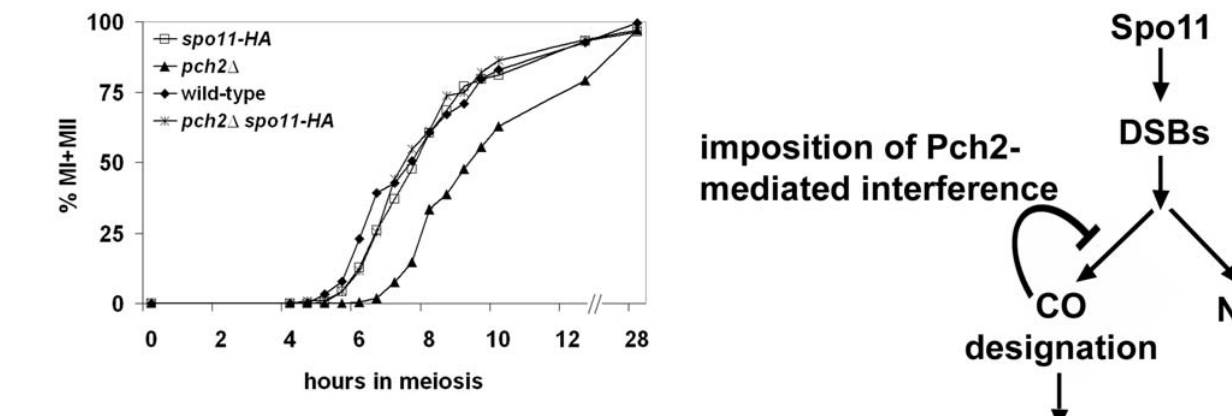
Figure 6. The pch2 D MI delay is suppressed by the spo11-HA hypomorph. Synchronous cultures were induced to undergo meiosis and progression past MI (MI 6 MII) was assayed in the NHY background for wild-type (diamonds), spo11-HA (open squares), pch2 D (triangles), and pch2 D spo11-HA (stars; Materials and Methods). A representative time course is Table 3). In other words, we propose Pch2-mediated CO control acts not only to uniformly space COs within the genome, but also to limit the overall number of COs. The same defect in pch2 D that disrupts interference could lead to longer heteroduplex tracts, causing the increases in gene conversion frequencies observed in pch2 D . .